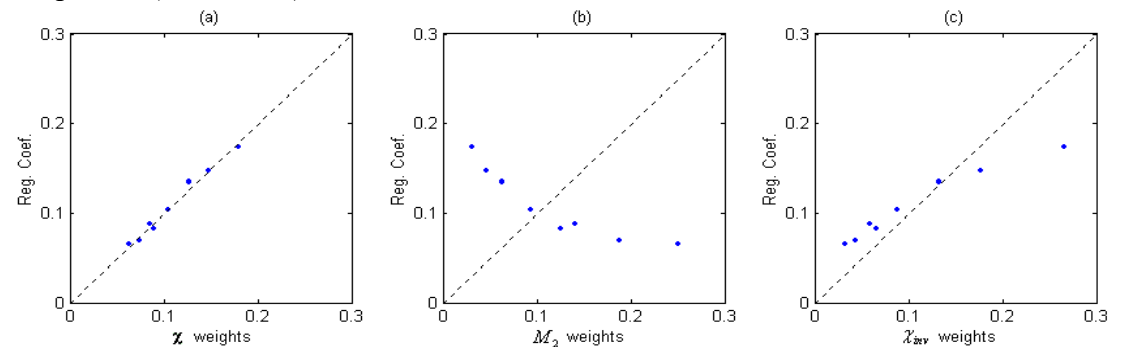
Figure 2. Plot of (a) χ weights vs. Reg. Coef., (b) M Reg. Coef.